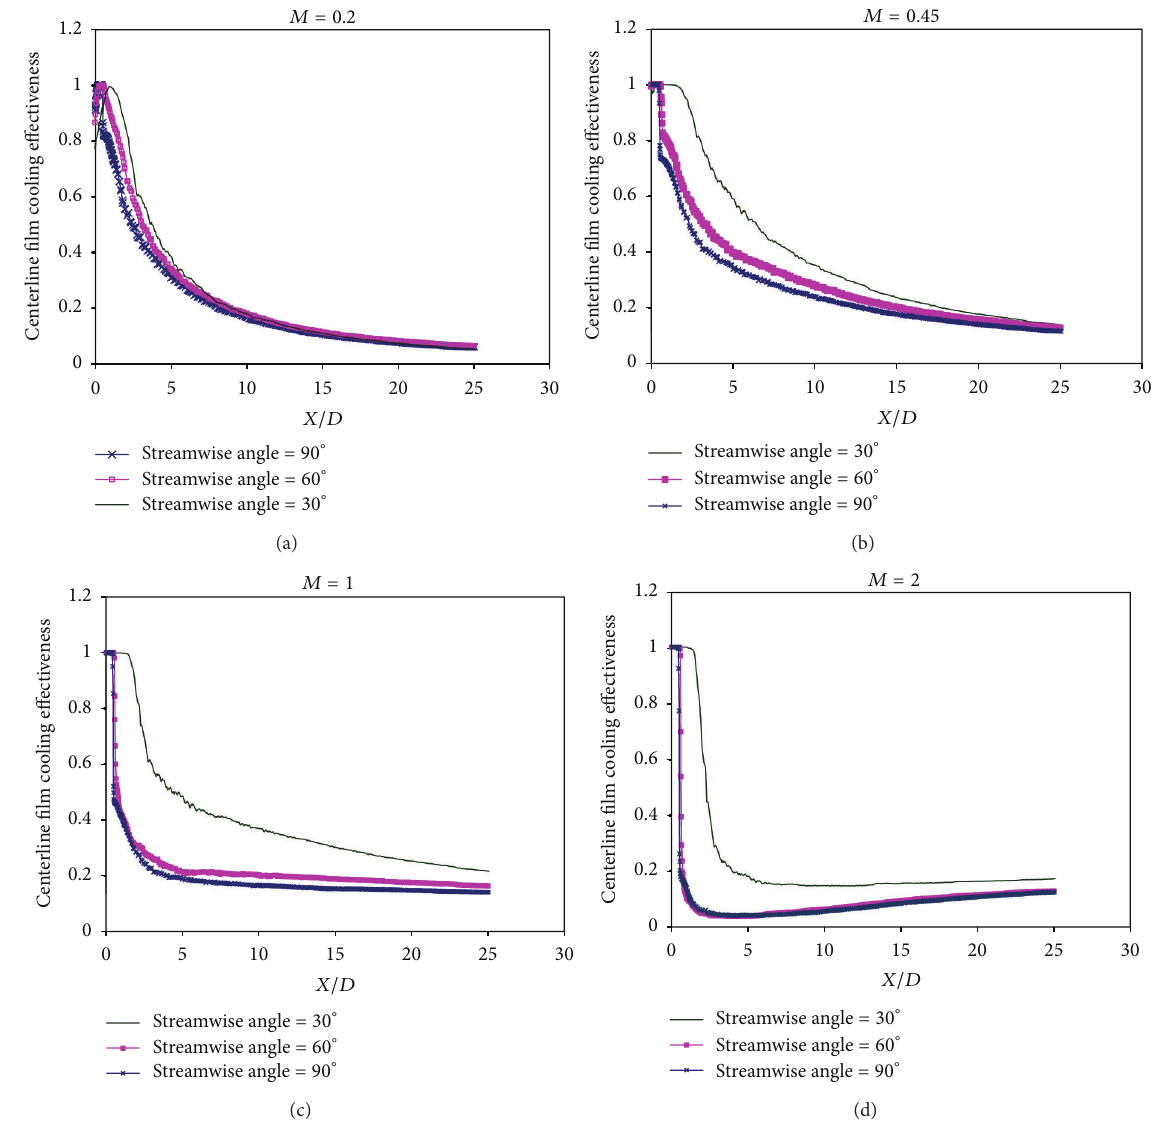
Figure 28: Variation of the centerline effectiveness with 𝑋/𝐷 for